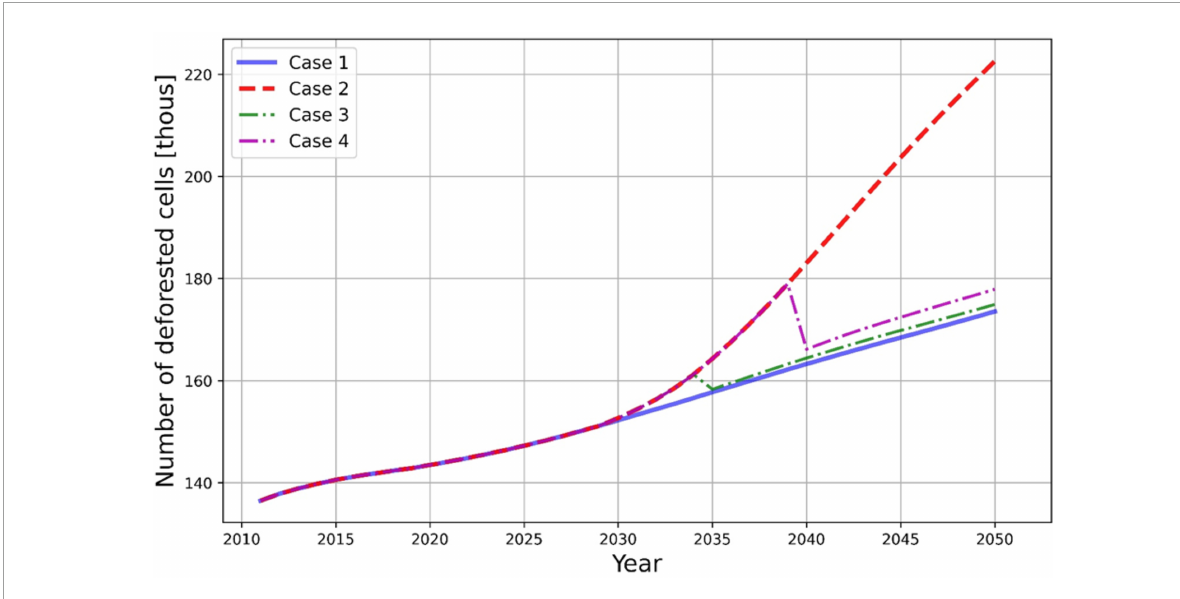
FIGURE13 Cumulative number of deforested cells in jurisdictional policy scenarios.